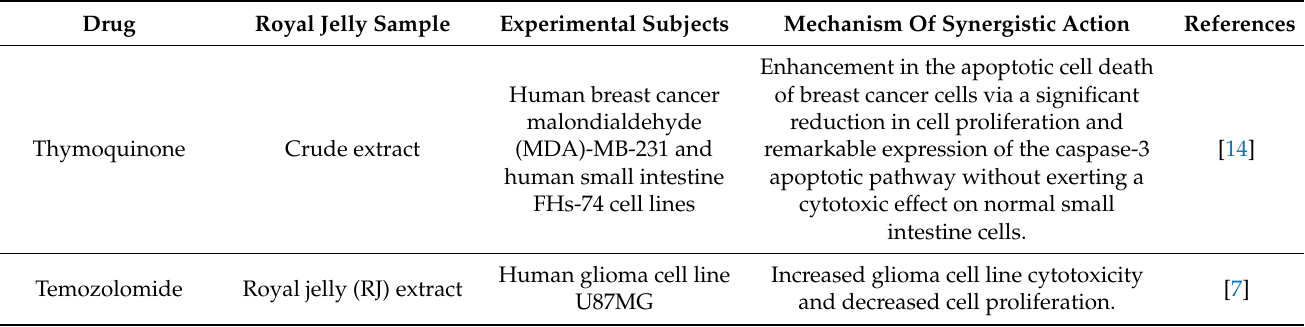
Table 1. Synergistic interaction between royal jelly and anticancer